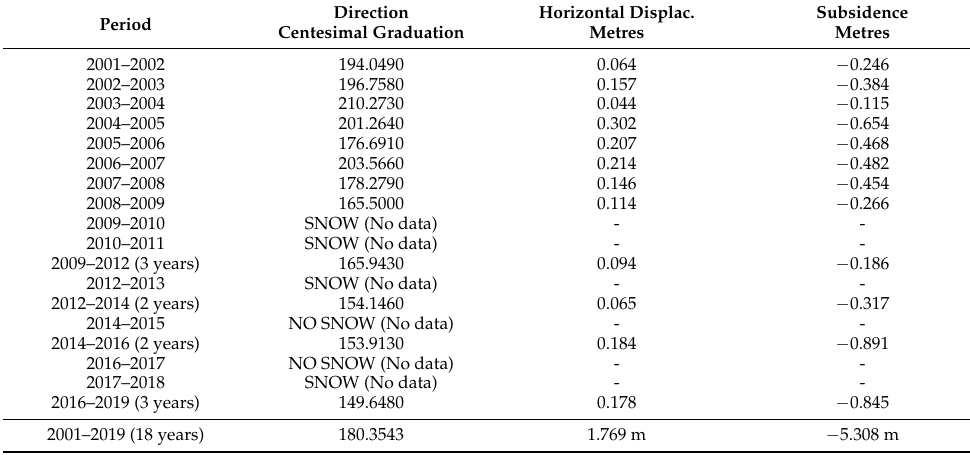
Table 2. Dynamic of steel rod 2 for 11 month periods (end of August-end of July) in consecutive years and periods of one month (August) [23]. Direction Horizontal Displac. Subsidence Period